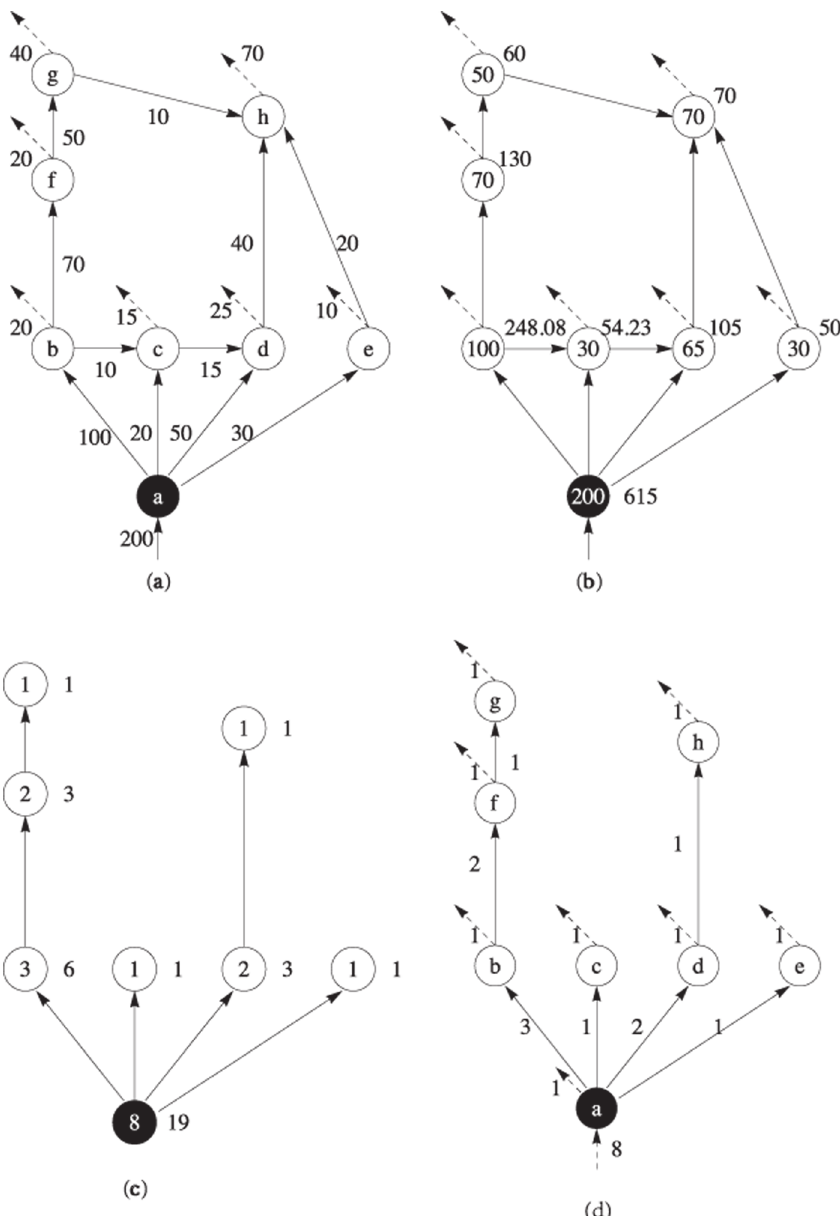
Figure 1. Comparison of different methods for calculating the allometric scaling of a hypothetical ecological flow network. (a) is a hypothetical network (the letter in each node is its index). The black node is the root, the numbers besides edges stand for flows, and the dashed lines represent dissipations; (b) shows the A i , and C i values inside and beside node i , respectively, by our method; (c) is a spanning tree of (a), and the numbers inside and beside vertex i are the A i and C i values calculated by Garlaschelli’s method; (d) is the implicated flow network of (c), and the numbers beside the edges are the flux values.